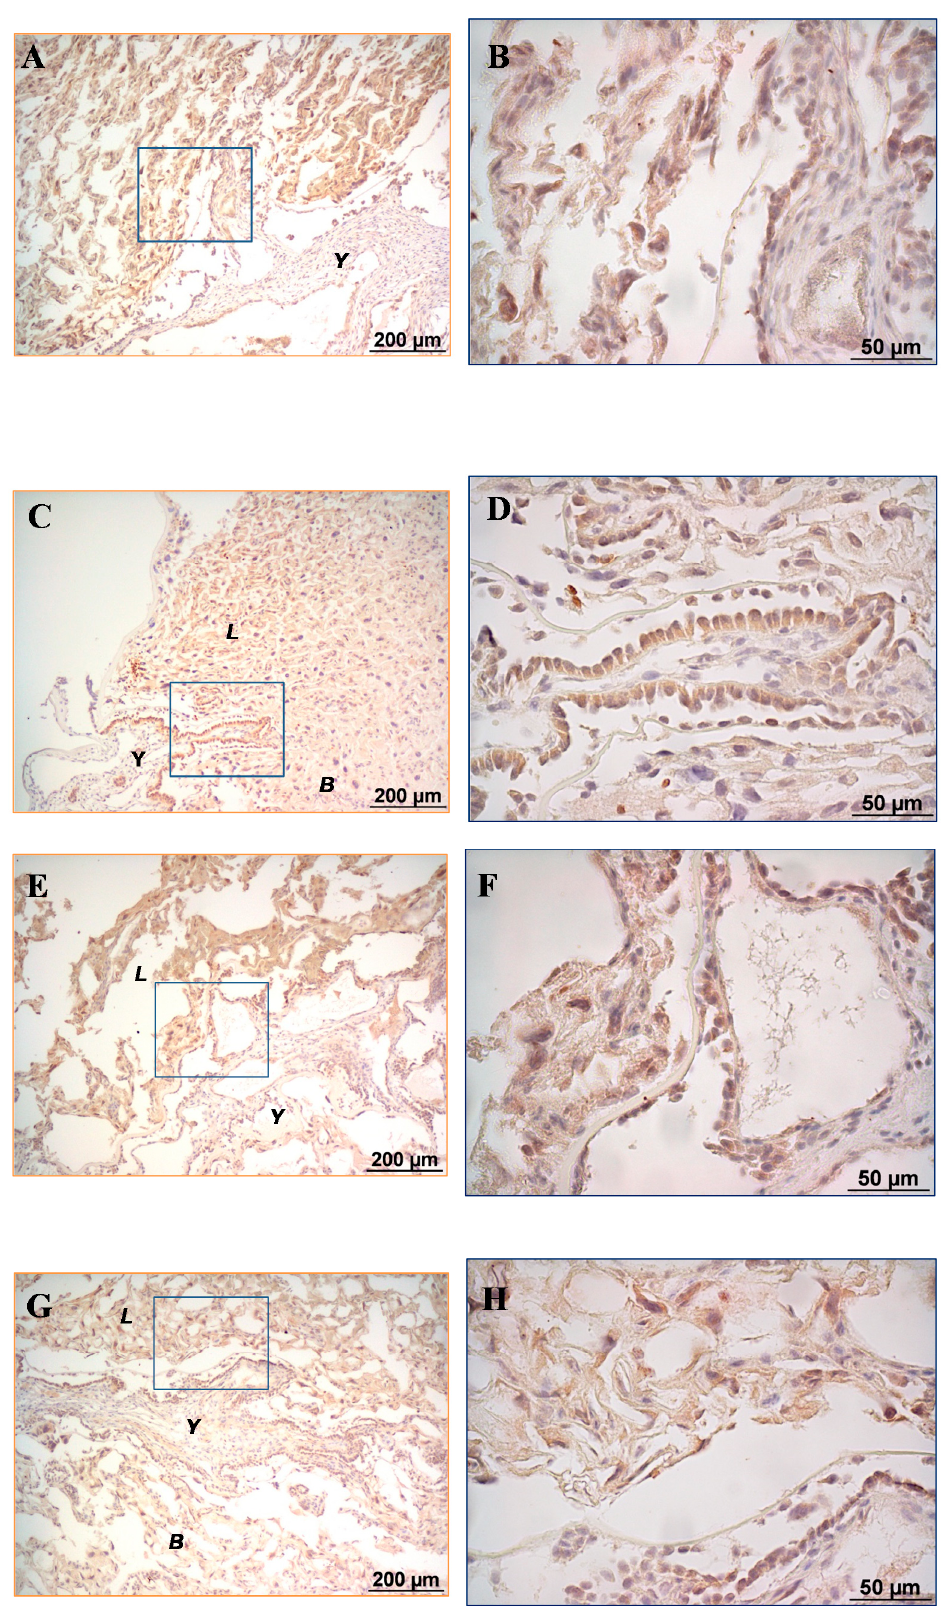
Figure 2. Immunostaining for leptin in the placenta. The images shown are representative of the different groups; the number of image samples analysed in the study was 4, 3, 2, and 2 for days 18, 19, 20, and 21, respectively. The corresponding enlargement of the framed area in ( A) , ( C ), ( E ), and ( G ) is on the right (i.e., ( B ), ( D ), ( F ), and ( H ), respectively). ( A ) and ( B ) Placenta of 18 days of gestation. Widespread positivity throughout the placenta and lack of clear separation of the basal and labyrinth zones. Positivity for leptin in the endothelial cells of the visceral yolk sac. ( C ) and ( D ) Placenta of 19 days of gestation. Visible separation of the basal and labyrinth zones. Placental leptin immunoreactivity is mainly observed in the labyrinth zone. The basal zone is negative for leptin immunoreactivity. Positivity for leptin immunoreactivity in the endothelial cells of the visceral yolk sac remains. ( E ) and ( F ) Placenta of 20 days of gestation. Same description as in C and D. ( G ) and ( H ) Placenta of 21 days of gestation. Same description as in ( C – F ). Light microscopy, immunohistochemistry of 5 µm thick paraffin-embedded transverse sections of placenta with a rabbit polyclonal anti-leptin antibody (ABC method, primary antibody diluted 1:1500). Scale bar: 200 µm in ( A) , ( C ), ( E ), and ( G ); 50 µm in the enlarged area ( B ), ( D ), ( F ), and ( H ). Abbreviations: B, basal zone; L, labyrinth zone; Y, visceral yolk sac. Leptin was also immunolocalised in the placenta, but the positivity pattern was different among the gestational days. Specifically, leptin positivity was widespread throughout the placenta at day 18 of gestation (Figure 2A,B), which exhibited poor separation of basal and labyrinth layers. However, from gestational day 19, a clear separation of the basal layer and labyrinth was observed (Figure 2C– H), at this moment the immunoreactivity for leptin was evident only in the cytoplasm of the labyrinth cells. The visible distinction of the basal and labyrinth zones at day 19 might be a signal of maturation of the labyrinth zone, which is in accordance with other studies that have evidenced that the labyrinth zone in rat develops with advancing pregnancy [31]. Changes in leptin positivity, from widespread throughout the placenta at day 18 to localised presence in the labyrinth zone from day 19 onwards, might be key in the sudden appearance of leptin at gestational day 20 in the AF, GC, stomach, and umbilical cord.